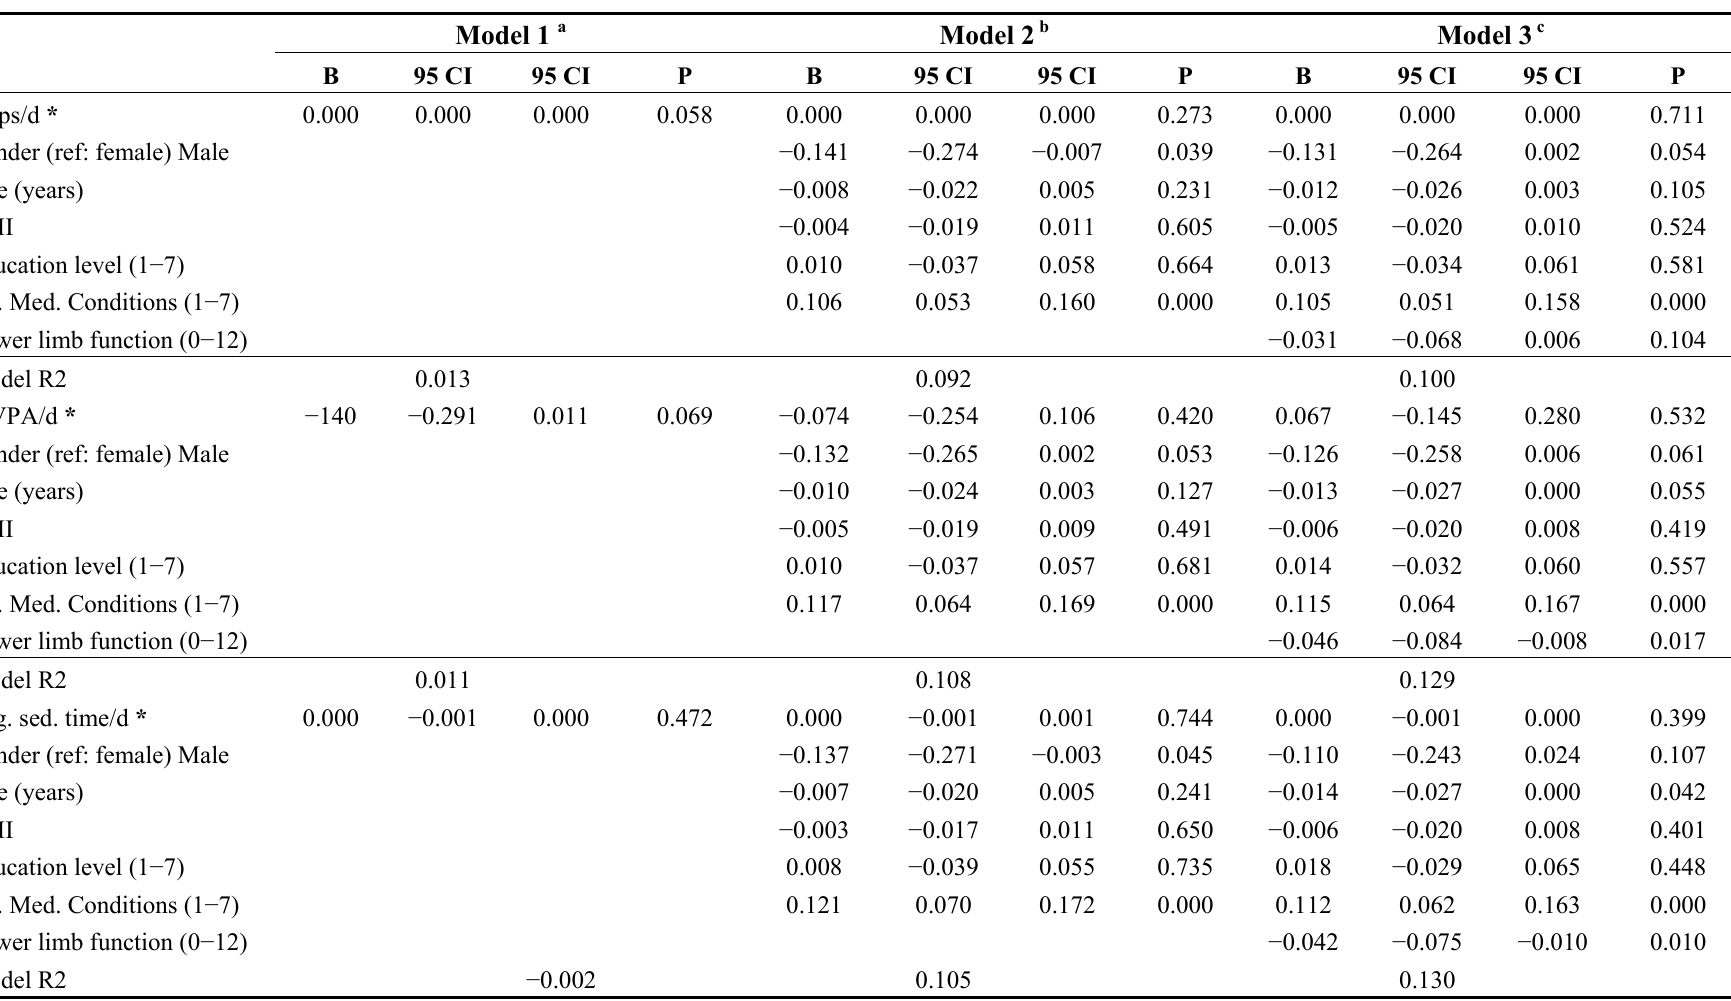
Table 4. Linear regression analysis on SF Mental scores with participant characteristics, number of medical conditions, lower limb function, MVPA, steps and sedentary